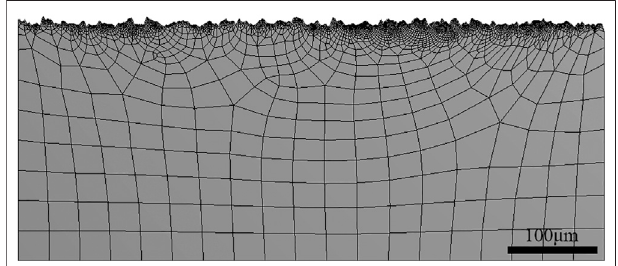
FIGURE 3 | Modeling and meshing of HP-13Cr SS surface after LA immersion.